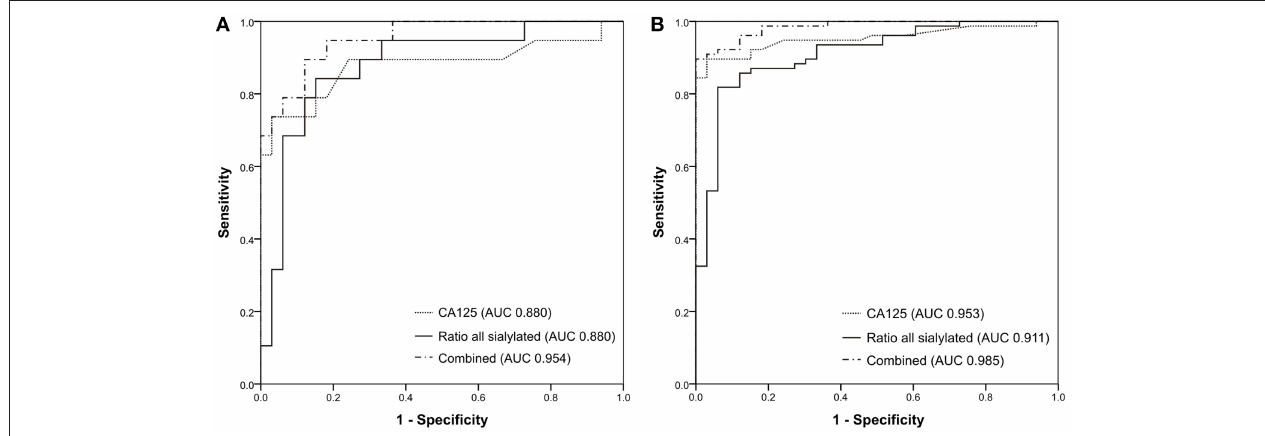
FIGURE 4 | ROC curves generated for (A) 33 healthy controls and 19 early-stage patients; (B) 33 healthy controls and 77 ovarian cancer patients.